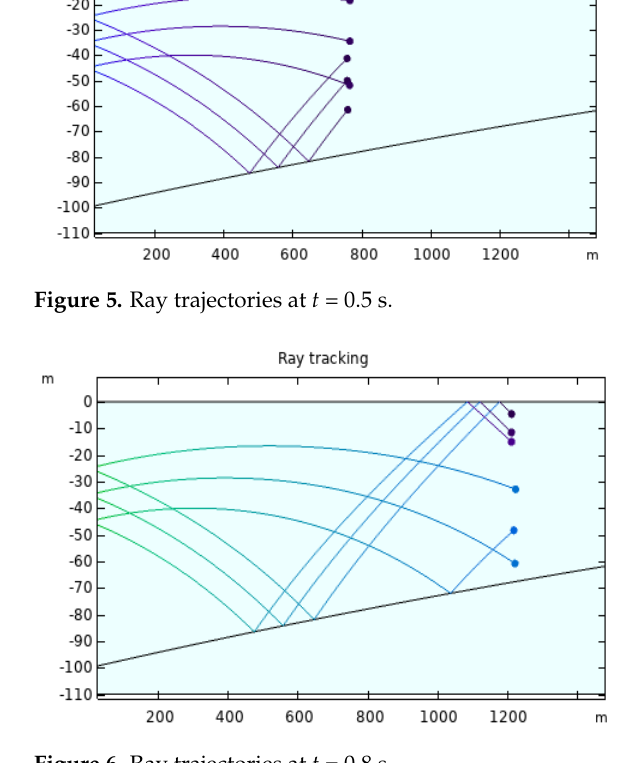
Figure 6. Ray trajectories at t = 0.8 s.